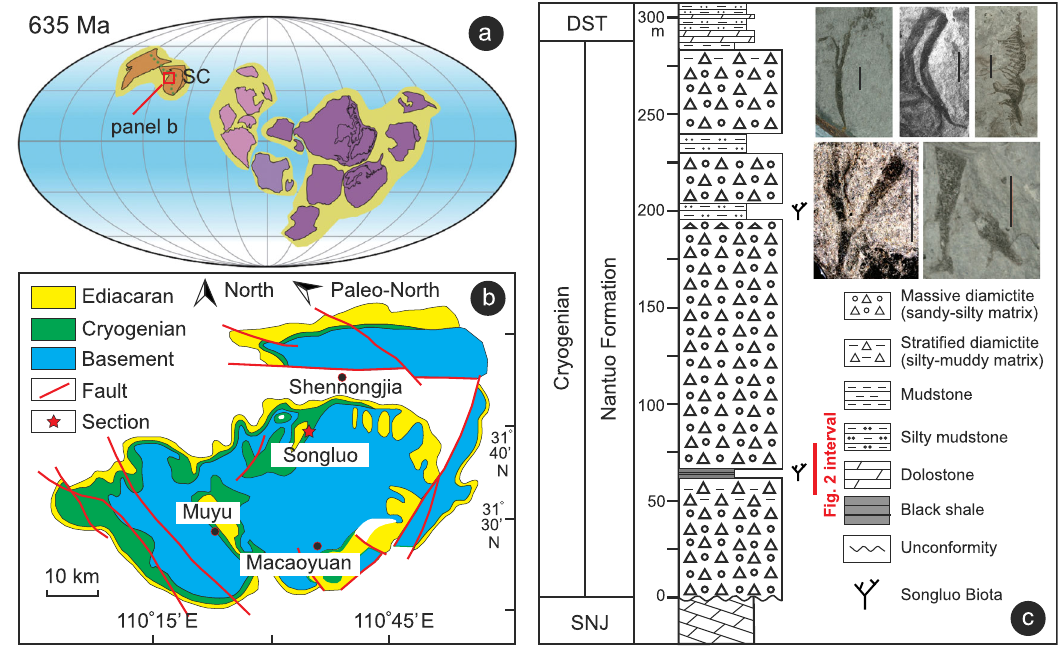
Fig. 1 | Location, stratigraphy, and fossils of the Songluo Biota. a Cryogenian paleogeographic map, from ref. 26 . Red rectangle marks area enlarged in panel ( b ). b Simpli fi ed geological map of Shennongjia area showing location of Songluo section (star). c Measured stratigraphic section of Nantuo Formation at Songluo